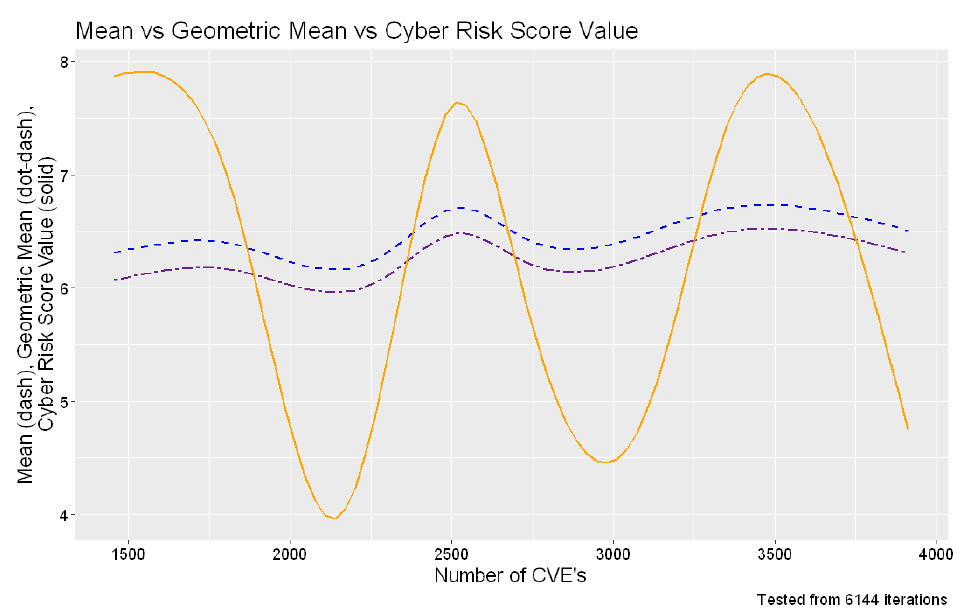
Figure 6. Mean vs. Geometric mean vs. Cyber Risk Score.